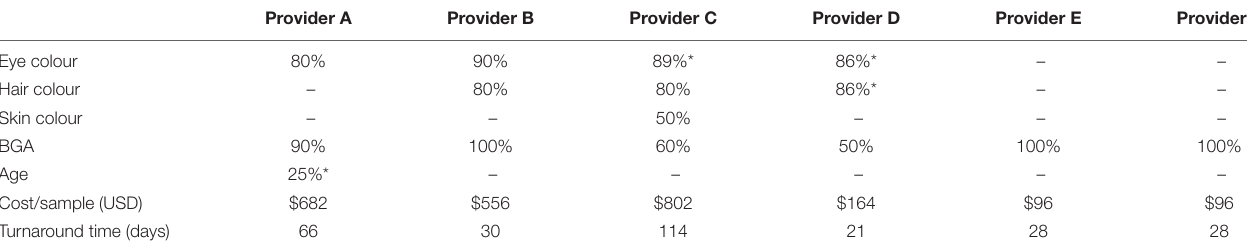
TABLE 3 | The prediction accuracy (%) of each service provider for eye, hair and skin colour, BGA, and age.